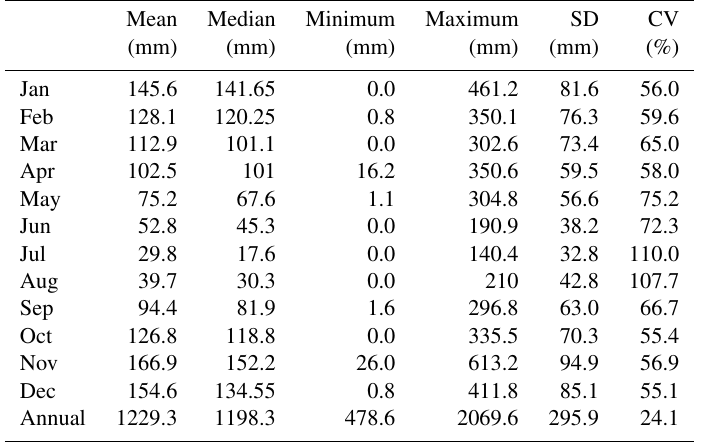
Table 1. Descriptive statistics of the monthly and annual rainfall distributions recorded at the Gioi Cilento weather station during the period of 1920–2018. SD: standard deviation; CV: coefficient of